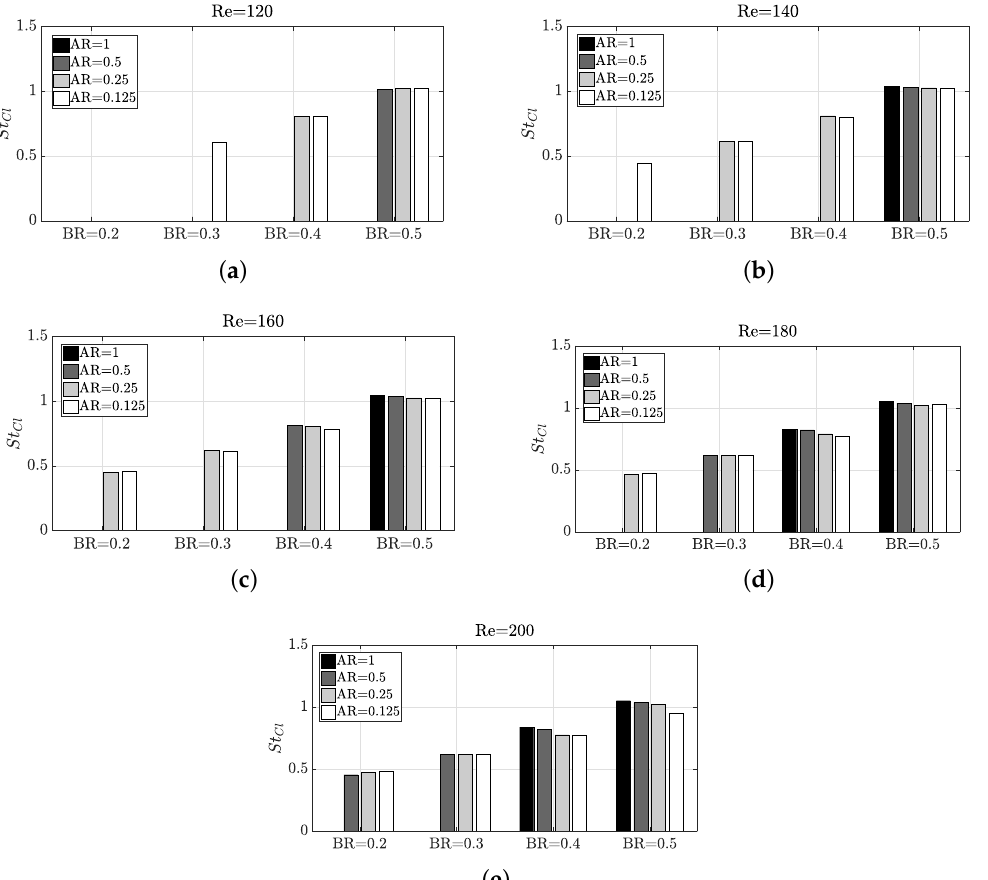
Figure 6. Impact of Reynolds number and geometry on Strouhal number in Cl